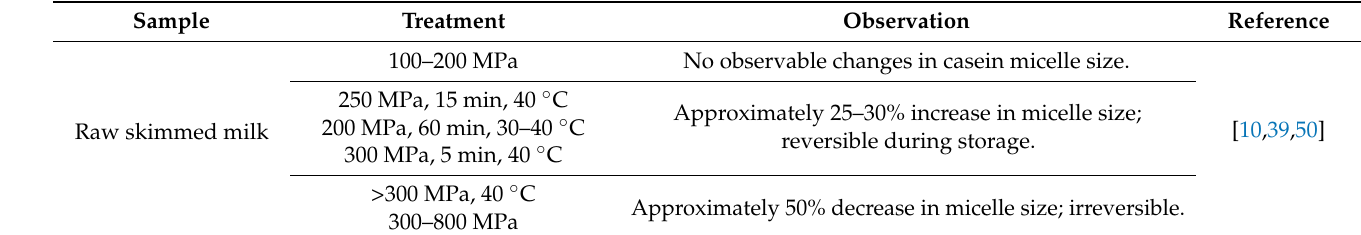
Table 2. Effects of HPP on casein micelle